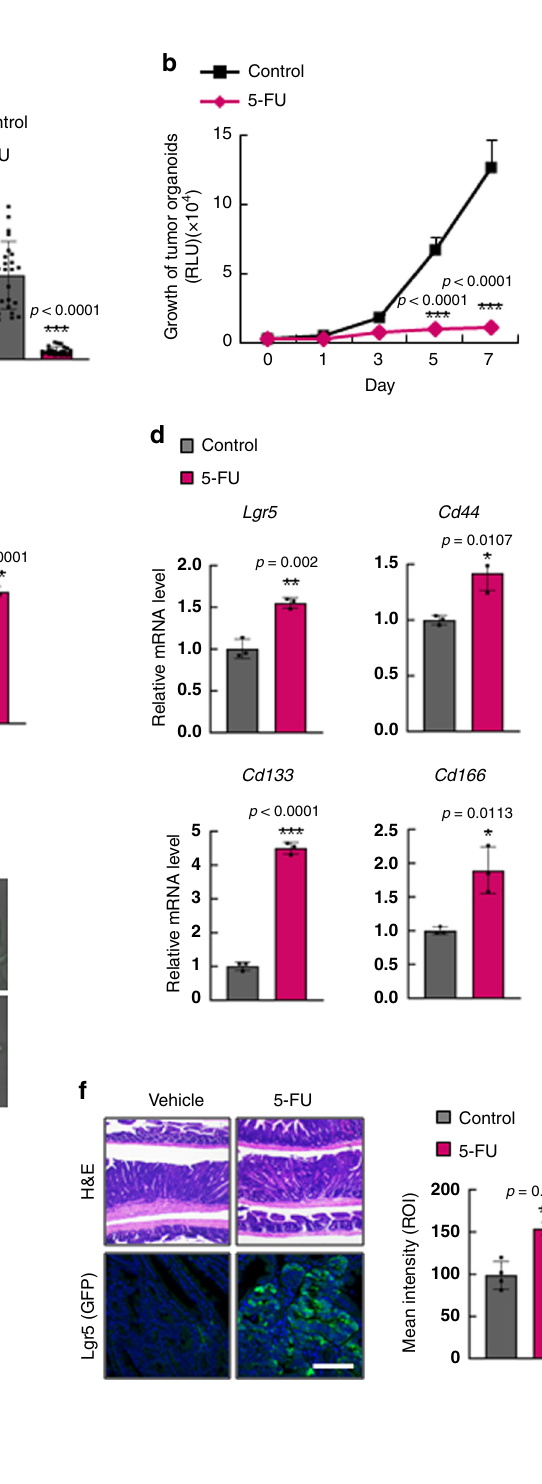
signi fi cantly elevated in the tumors of 5-FU-treated Apc Min/ + / Lgr5 EGFP mice, and that these levels were strongly correlated with the expression of Lgr5 (Fig. 2e, f). Moreover, 5-FU treatment of mouse tumor organoids derived from Apc Min/ + /K-Ras G12D LA2/ Lgr5 EGFP mice and in vivo injection of 5-FU to Apc Min/ + /K- Ras G12D LA2/Lgr5 EGFP mice con fi rmed increased expression of β - catenin and Lgr5 (GFP), showing that 5-FU-induced activation of the Wnt/ β -catenin signaling pathway and CSCs also occur in an advanced murine CRC model (Supplementary Fig. 2a,